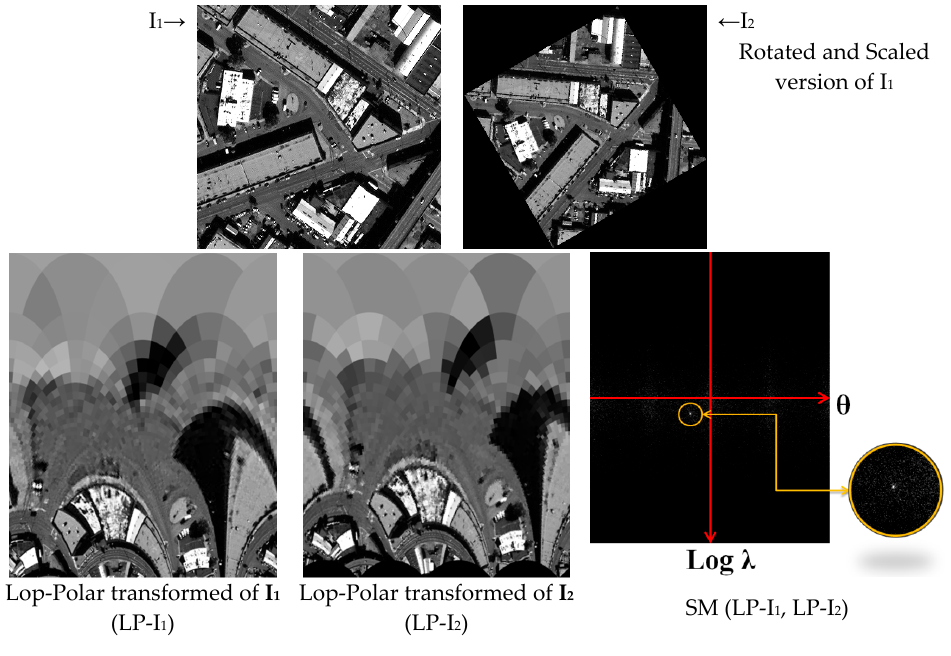
Figure 13. The estimation of rotation and scale difference between two images via the Log-Polar transformation.